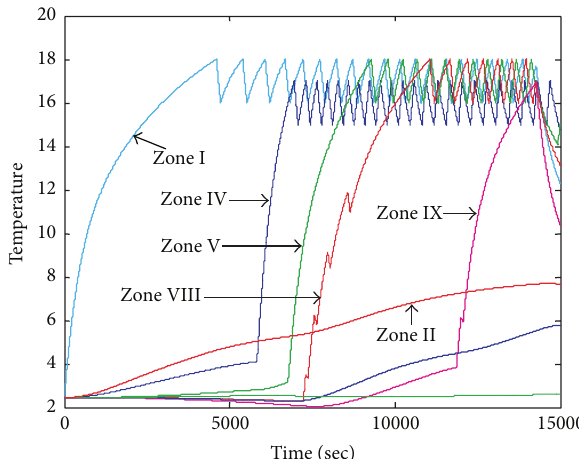
Figure 16: Temperature profiles of zones (cascade movement sce-